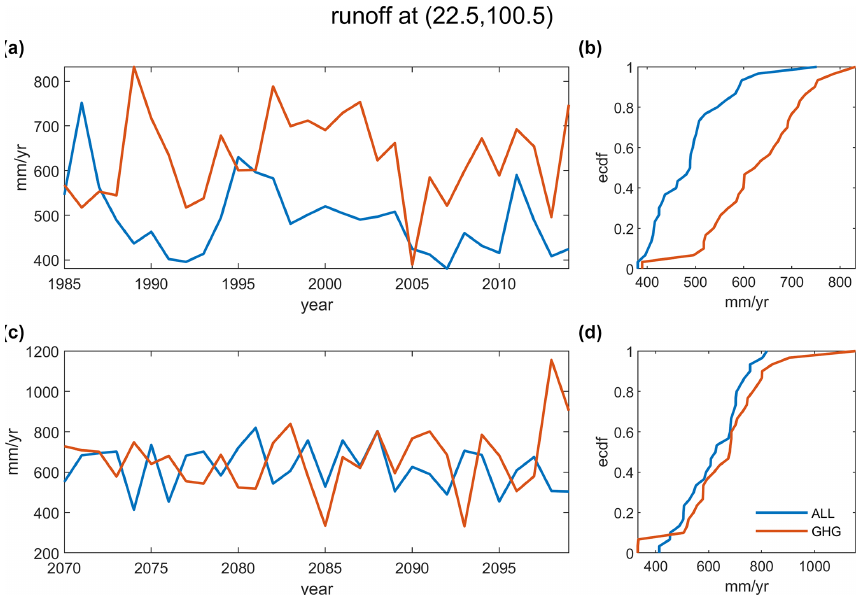
Figure A4. The 30-year mean annual runoff time series and eCDF from all forcing and GHG-only forcing simulations for historical period ( a , b ), and SSP5-8.5 period ( c , d ) at (22.5 ◦ N, 100.5 ◦ E), where the K-S test was rejected ( R ) in the historical period and failed to reject ( F ) in the SSP5-8.5